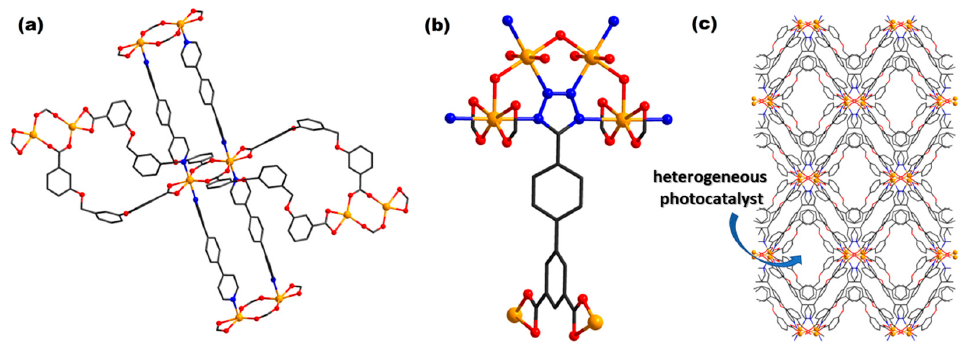
Figure 3. Coordinative site of complexes {[Zn(pmbd)(dpb)]·dpb} n ( a ) and (adapted from ref.